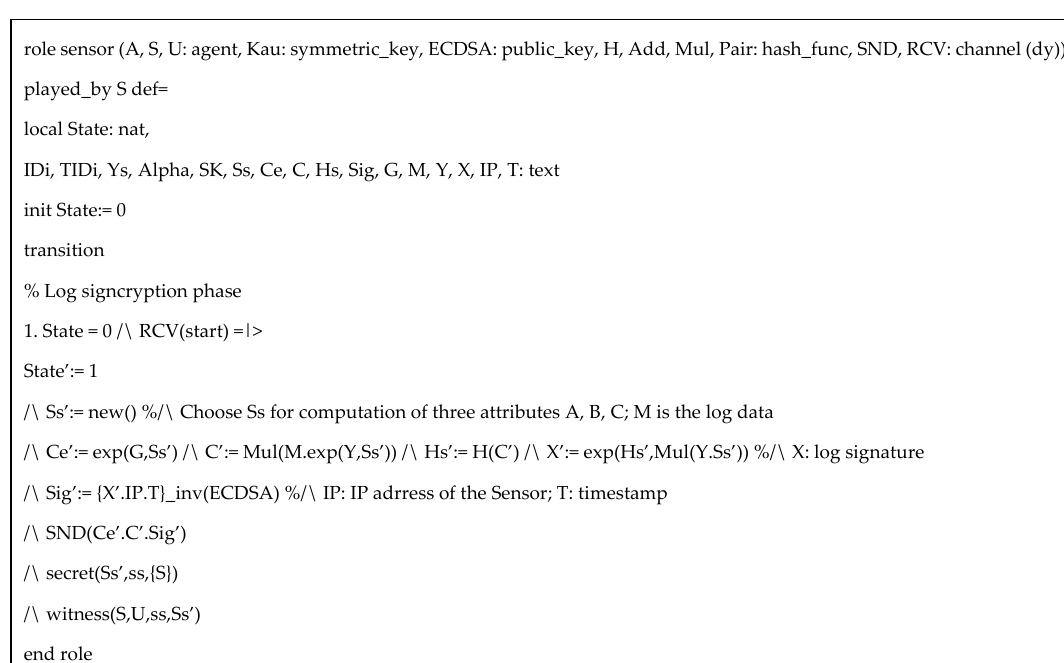
Figure 5. HLPLS specification of sensor role.